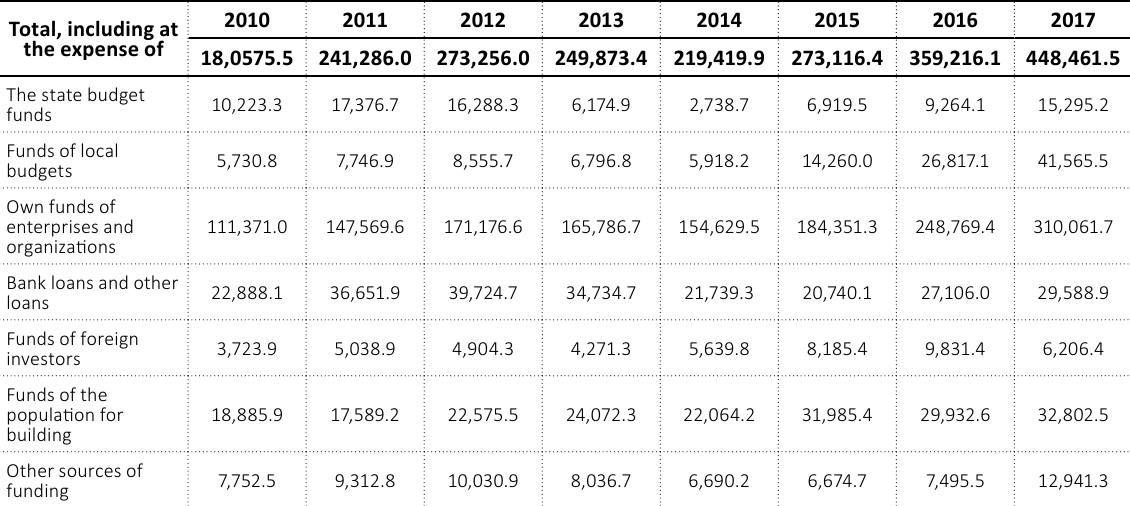
Table 3. Capital investment by sources of financing for 2010–2017* (UAH